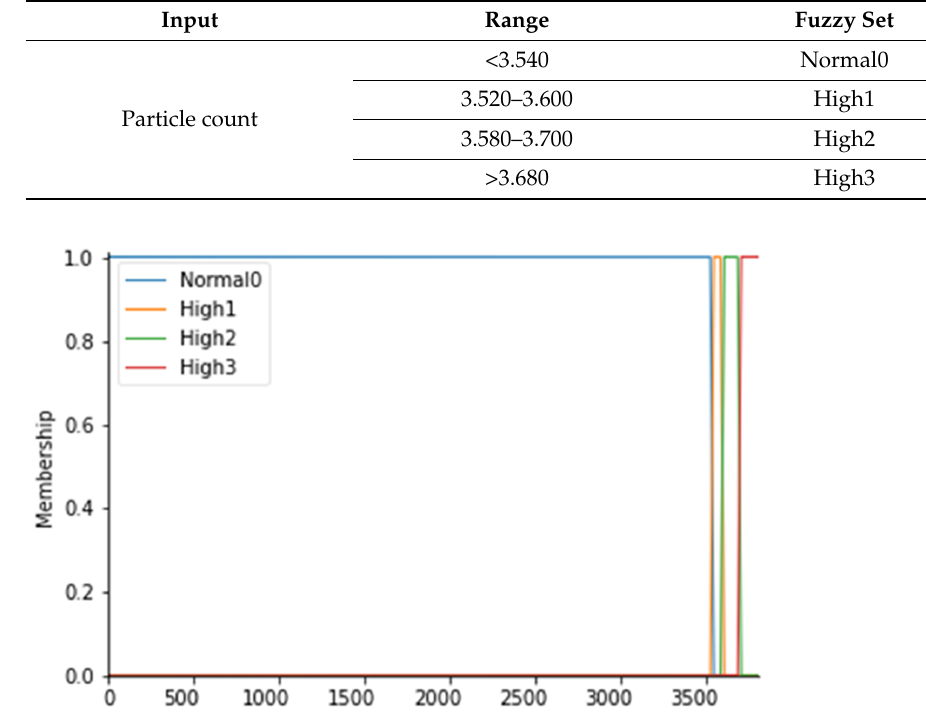
High2 Figure 4. T membership functions.